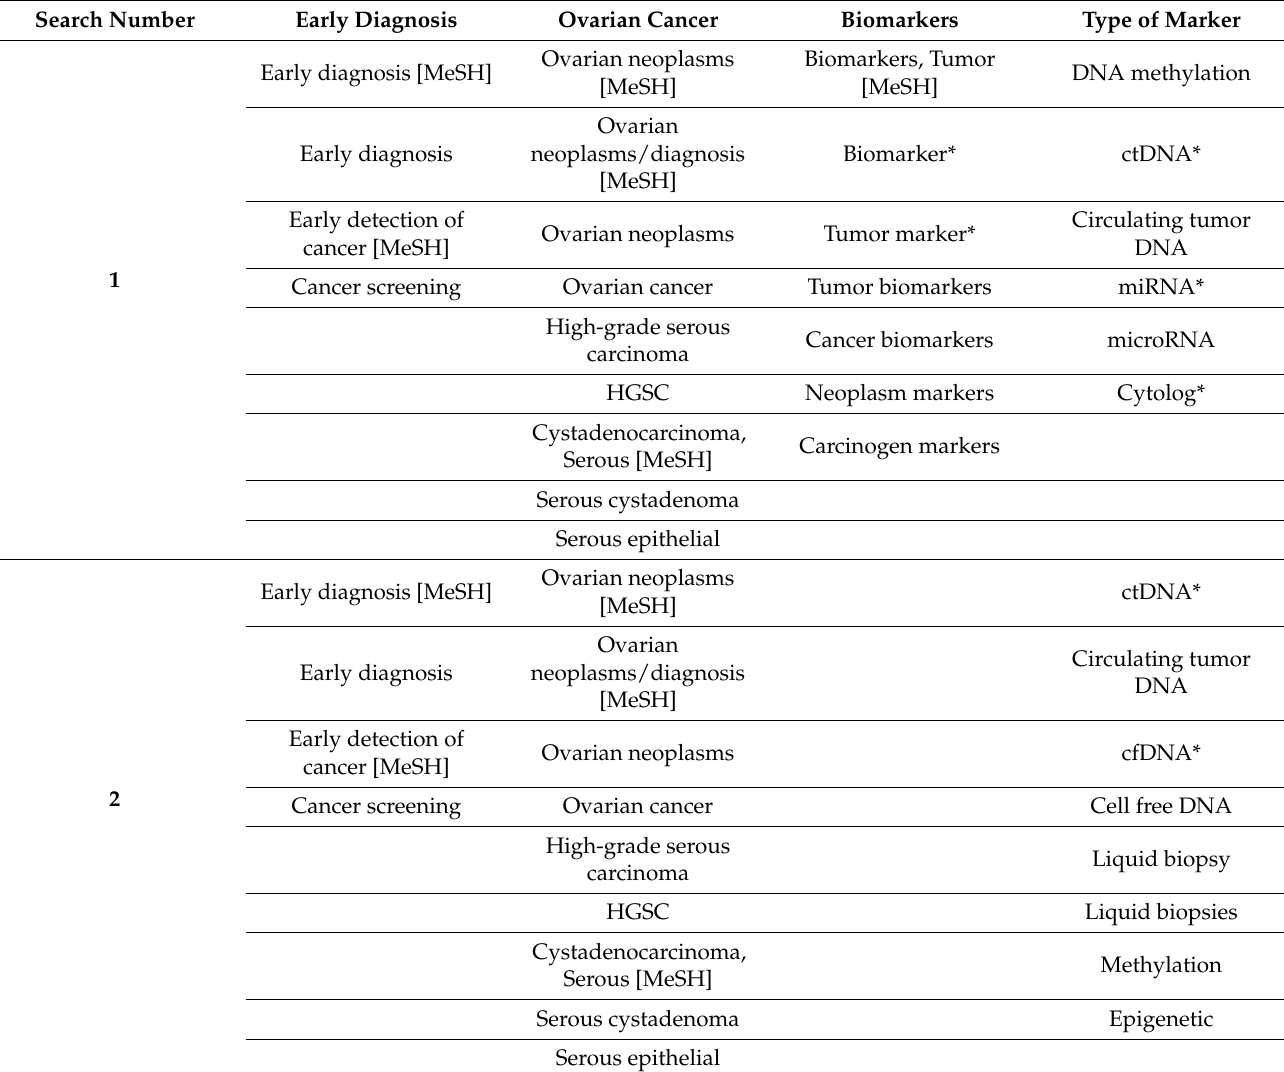
Table 3. Review search terms. Two searches were conducted in PubMed’s Medline and Elsevier’s Embase and Scopus. MeSH terms were used only in Medline. Terms were combined using Boolean logic statements: Within-column terms were combined with “OR”; between-column terms were combined using “AND”. The asterisk (*) represents a wildcard symbol used to broaden the search to all terms with the previous